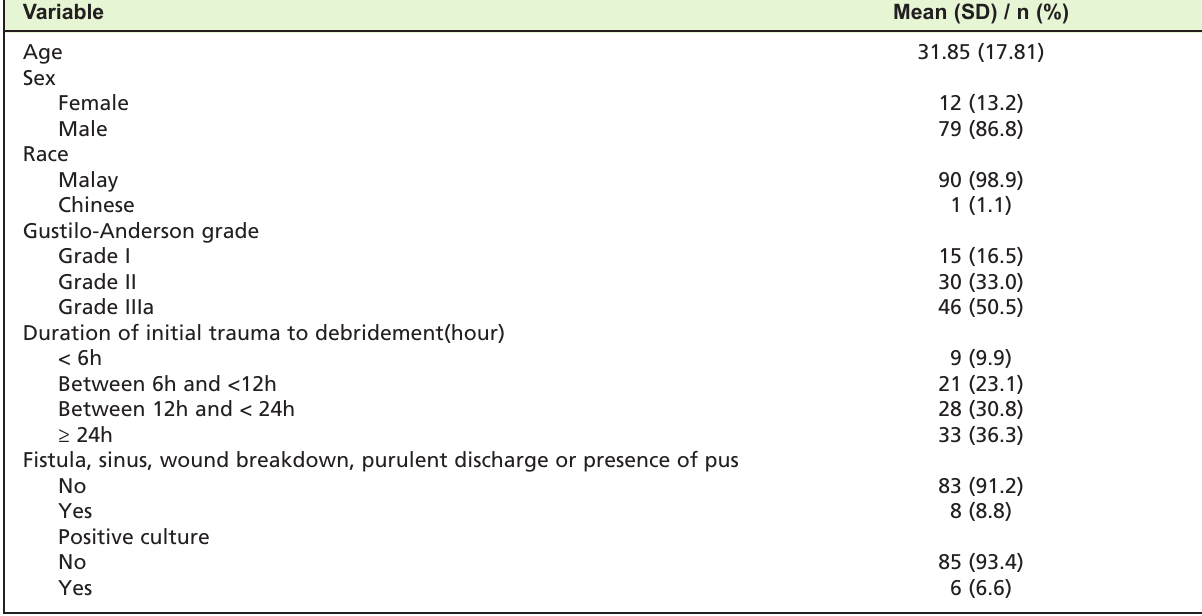
Table I: Sociodemographic and clinical characteristics of patients (n=91)